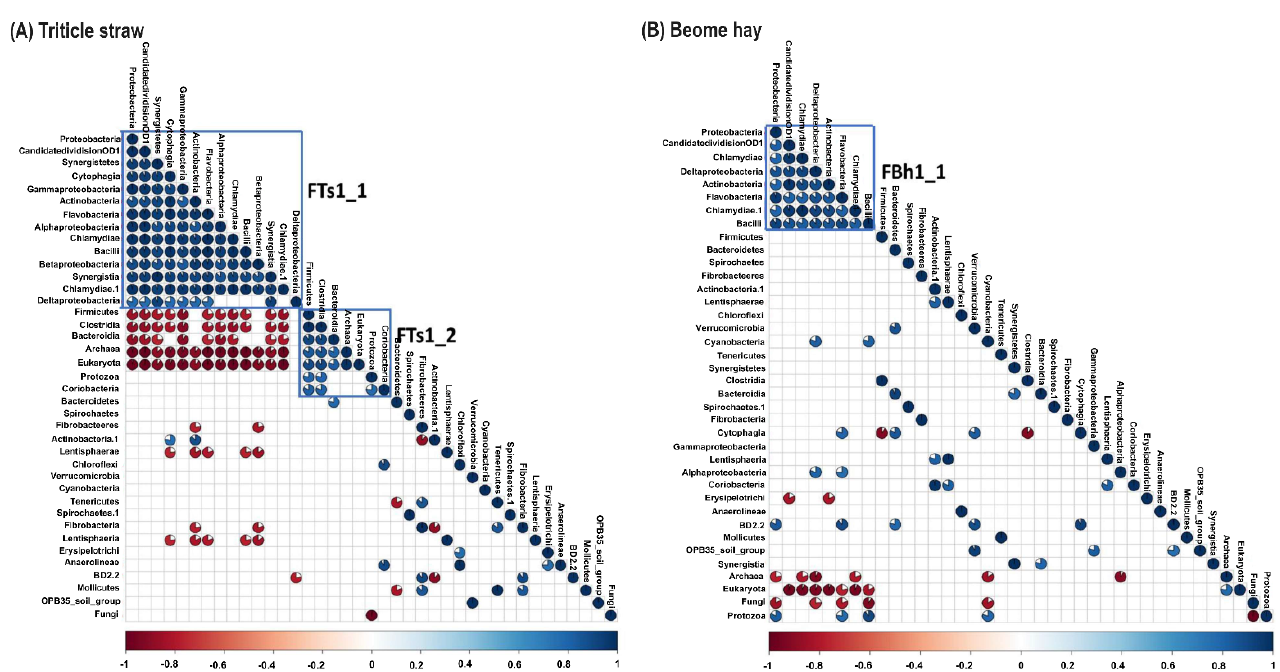
Figure 4. Correlation matrixes of all the phylotypes at the ranks of king, phyla, and class in the rumen solid samples of muskoxen on ( A ) triticale straw and ( B ) brome hay during fall. Squares denotes the phylotypes which can be detected at least 75% analyzed samples. Blank squares denote P > 0.05, while the colored pie filled squares denote P ≤ 0.05; both the sector size and the colors denote the correlations, and the colors are presented in the scale bar denoting the nature of the correlation with 1 indicating perfect positive correlation (dark blue) and 1 indicating perfect negative correlation (dark red) between two microbial populations.